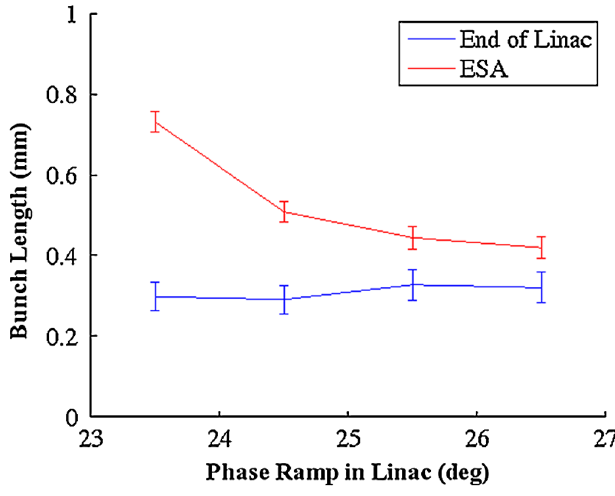
FIG. 4. (Color) RMS bunch length variation with linac phase [length measured at end of linac shown in blue, and the value extrapolated from the measured phase space using R ð 5 ; 6 Þ shown in